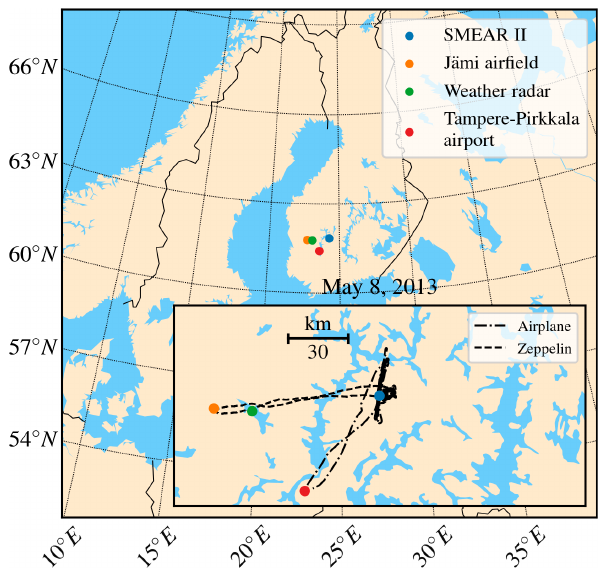
Figure 3. The locations of the Tampere-Pirkkala airport (ICAO: EFTP), Jämi airfield (ICAO: EFJM), Ikaalinen weather radar and SMEAR II station marked on a map. As an example, the aircraft measurement tracks on 8 May 2013 are